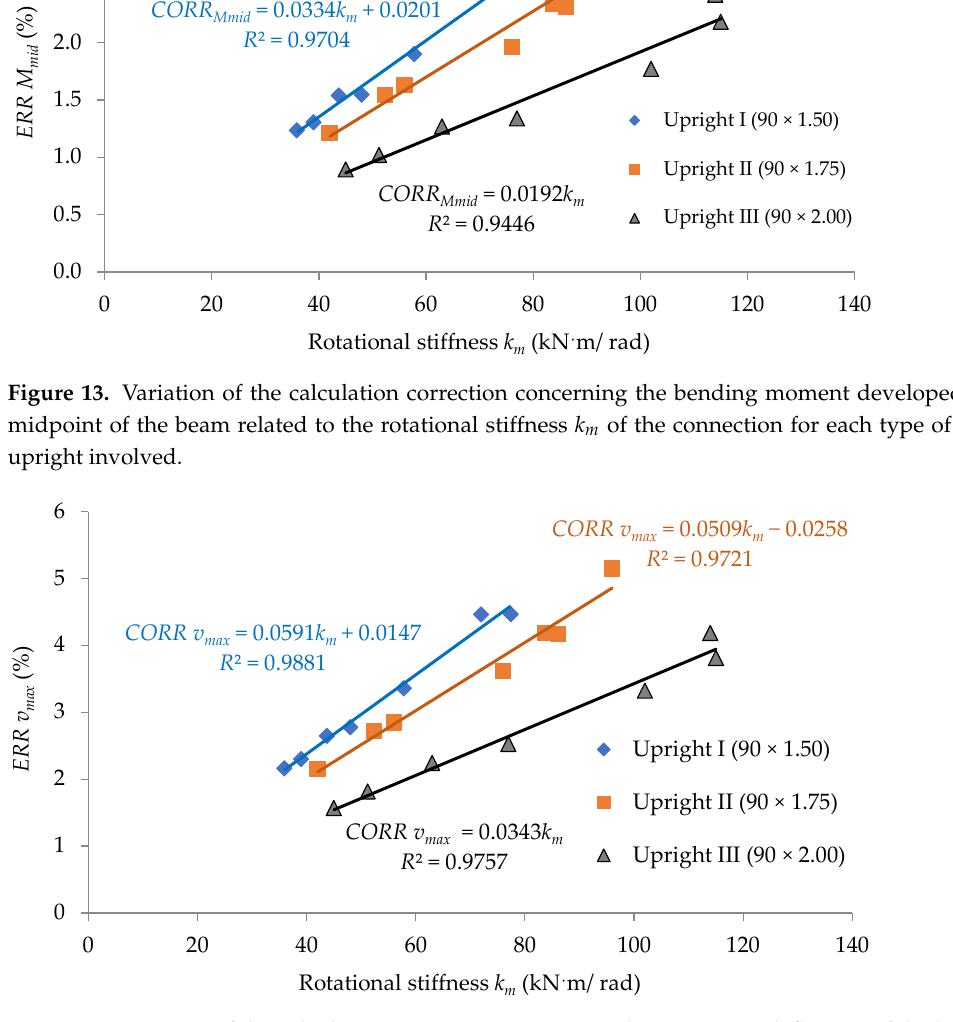
Figure 14. Variation of the calculation correction concerning the maximum deflection of the beam related to the rotational stiffness k m of the connection for each type of the upright involved.